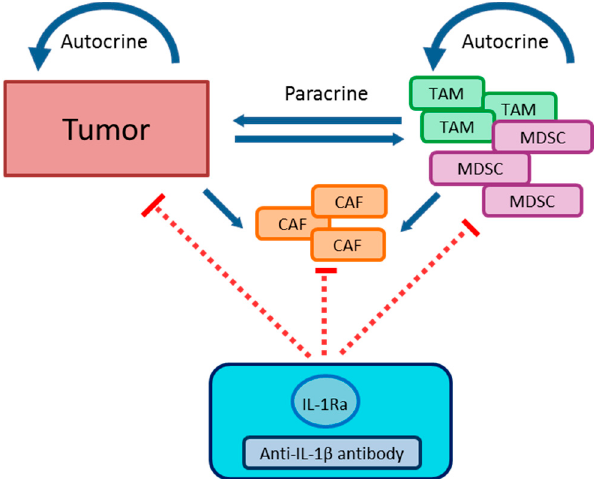
Figure 3. Effects of IL-1 in the tumor microenvironment. IL-1 is expressed by tumor cells, and predominantly by regulatory immune cell populations such as TAM and MDSC in the tumor microenvironment. The interleukin exerts pro-tumorigenic autocrine and paracrine effects on several levels in these cell types as well as in CAF which themselves do not generate IL-1 (blue arrows). Protumorigenic effects of elevated IL-1 on these different cell types are counter-acted by administration of IL-1Ra which competes with IL-1( α and β ), and thereby prevents IL-1 signaling (red arrows). In numerous studies, TAM and MDSC were demonstrated to specifically produce IL-1 β . In accordance, application of IL-1 β specific antibodies intended to prevent induction of IL-1 signaling was shown to confer anti-tumorigenic effects as well.